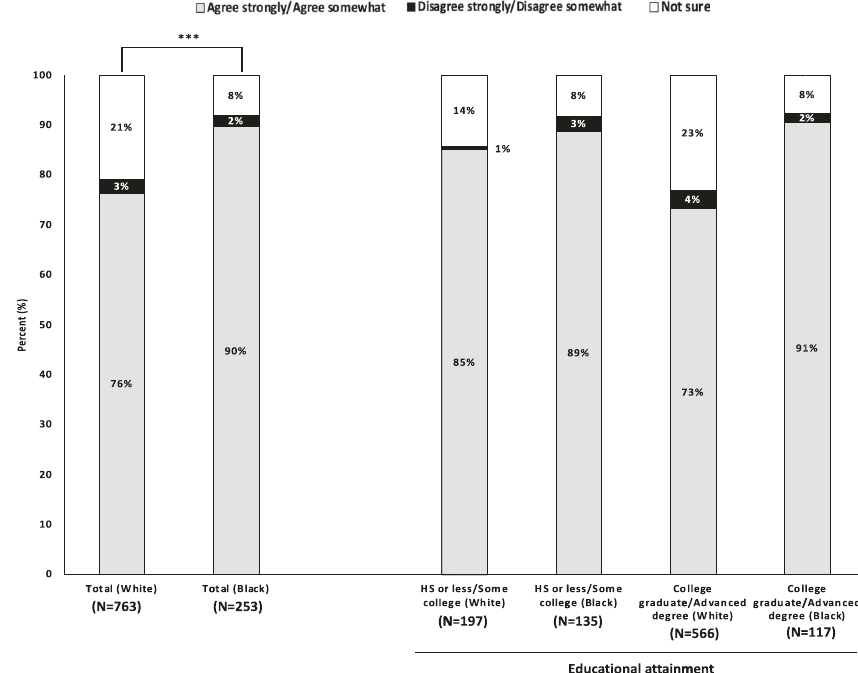
Fig. 1 Patient views on the use of pharmacogenomics to guide health care delivery, by self-reported race and educational attainment. N values re fl ect the number of surveys returned from each self-reported racial group regarding clinical visits, not individual/unique patients. Survey responses of patients with “ Unknown ” educational level are not shown. Percent values may not sum to 100% due to rounding effects. Pearson chi-squared tests comparing total sample of self-reported White respondents and total sample of self-reported Black respondents. * P ≤ 0.05, ** P ≤ 0.01, *** P ≤